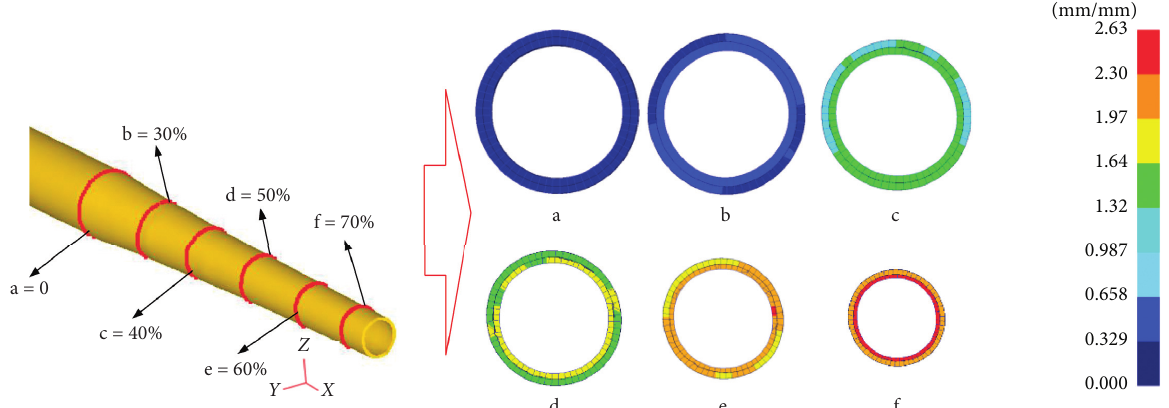
Figure 8: The equivalent strain nephogram of the outer and inner tubes at different reduction